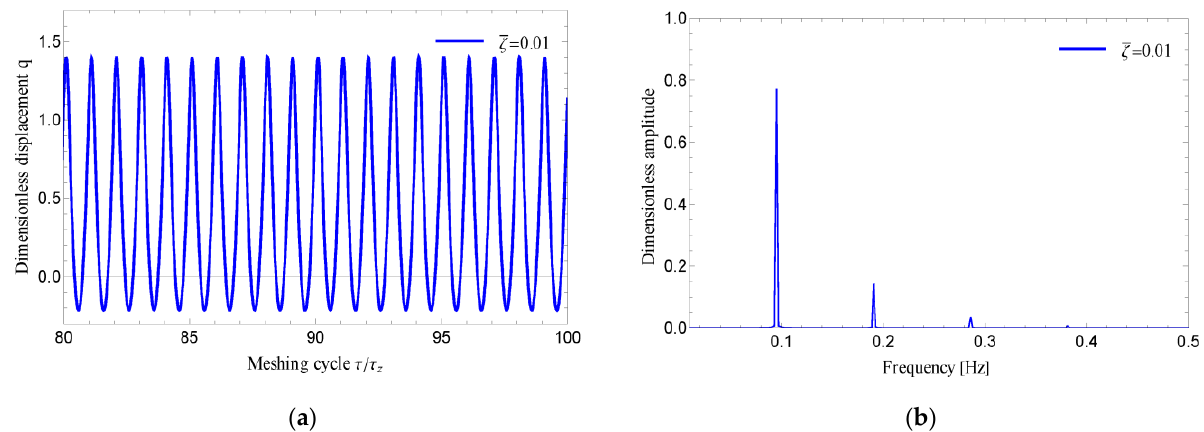
Figure 31. The dynamics characteristics for the upper branch when 𝜁̅ = 0.01 : ( a ) time history diagram; ( b ) FFT spectrogram.